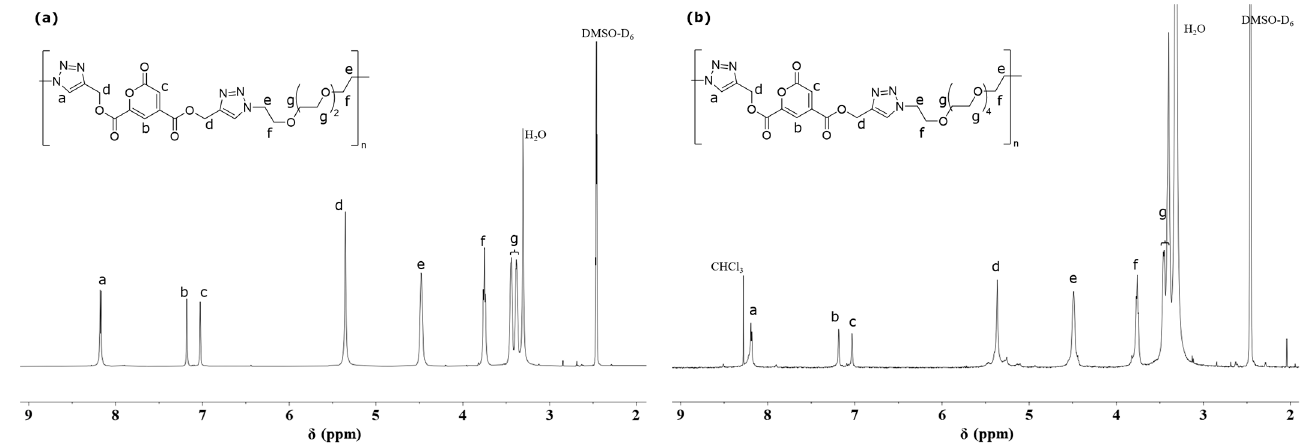
Figure 1. 1 H NMR spectra of ( a ) P1 and ( b ) P2 in DMSO-d 6 at 20 °C.